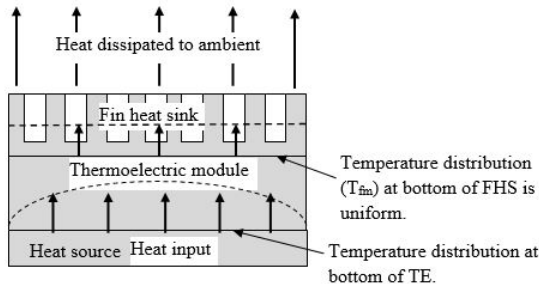
Figure 2. Thermal cooling with an air ‐ cooled FHS and TE (thermoelectric).